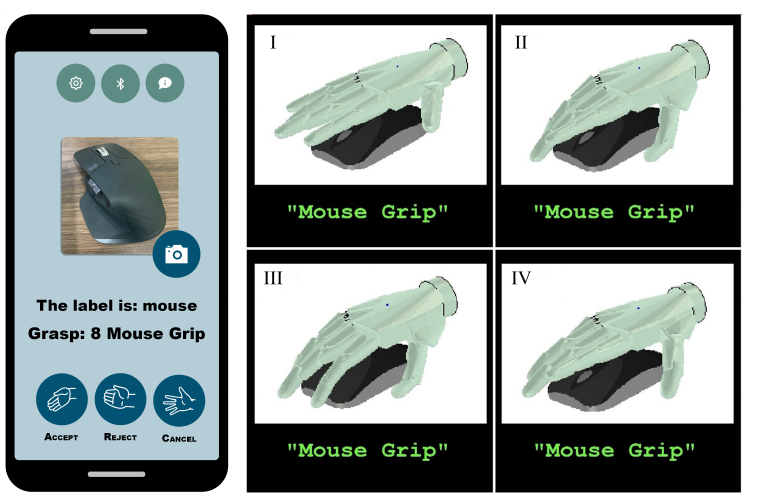
Figure 9. On the left, the visual feedback presented to the user on the Android app. Beside it is the animation of the grip, which is shown to the user via the Galileo Hand’s LCD